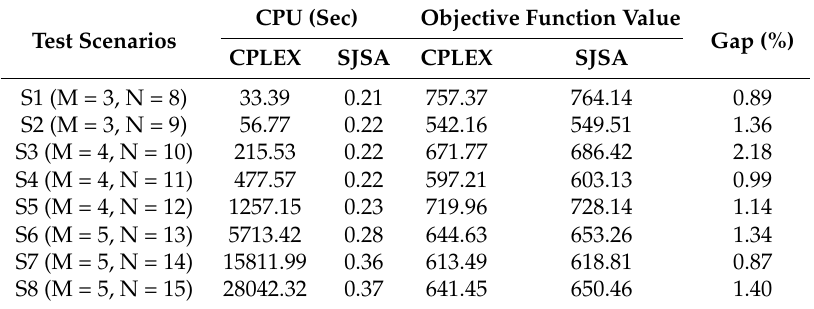
Table 4. Performance comparison of CPLEX and